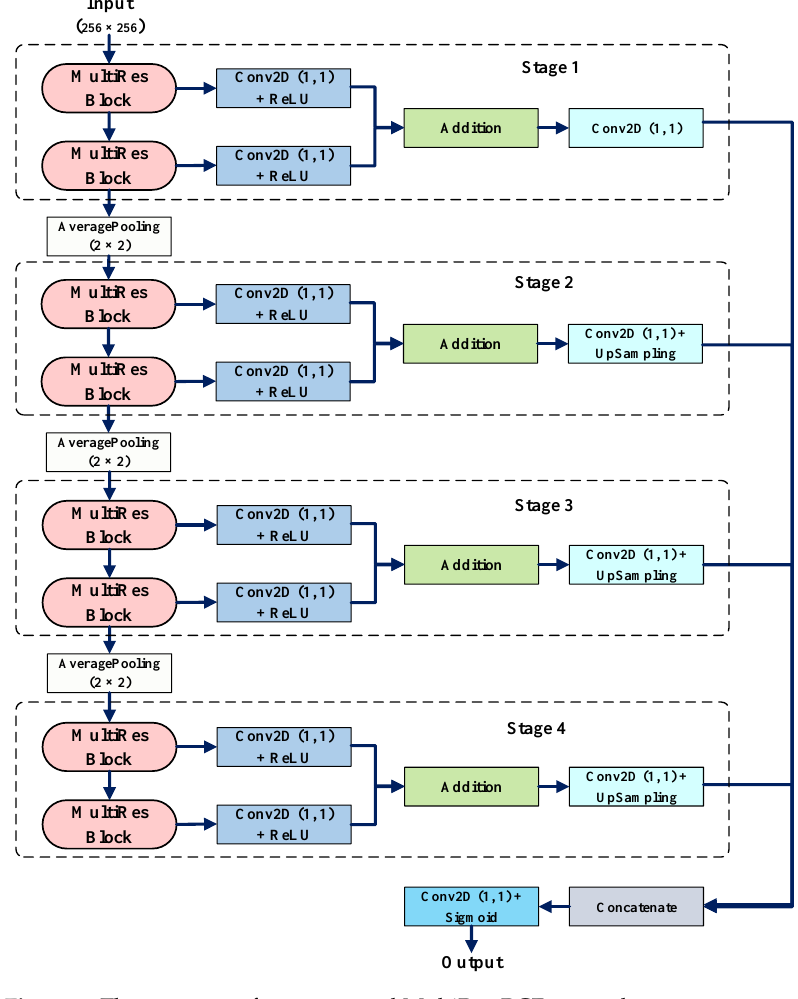
Figure 3. The structure of our proposed MultiRes-RCF networks.